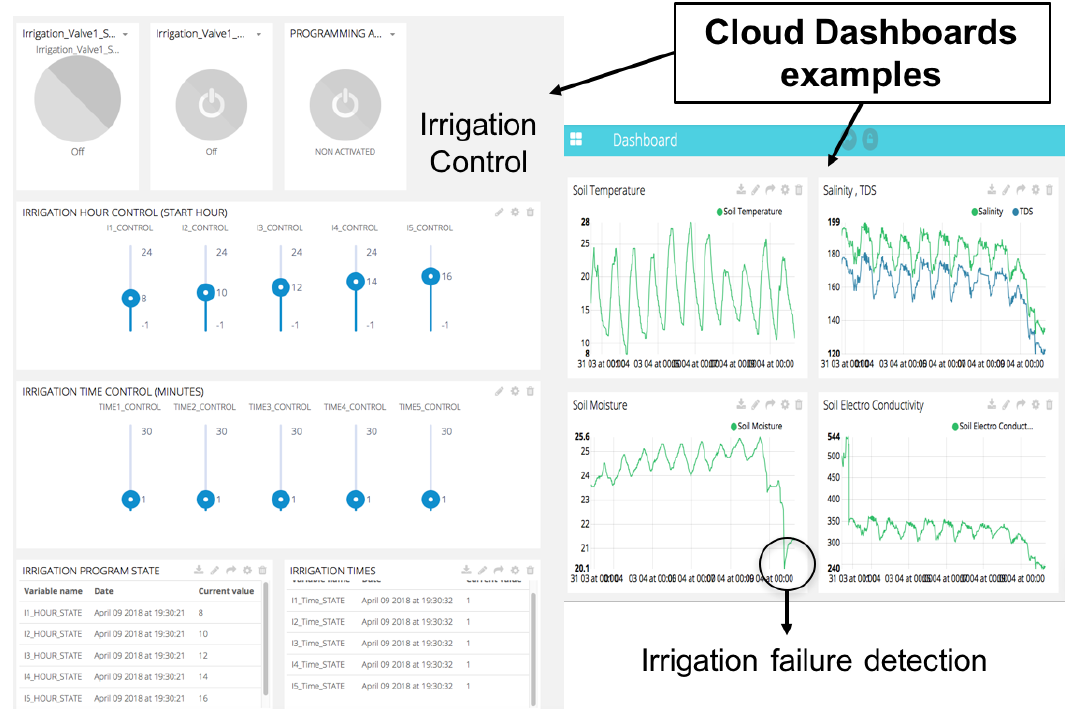
Figure 12. Dashboards designed for irrigation programming and